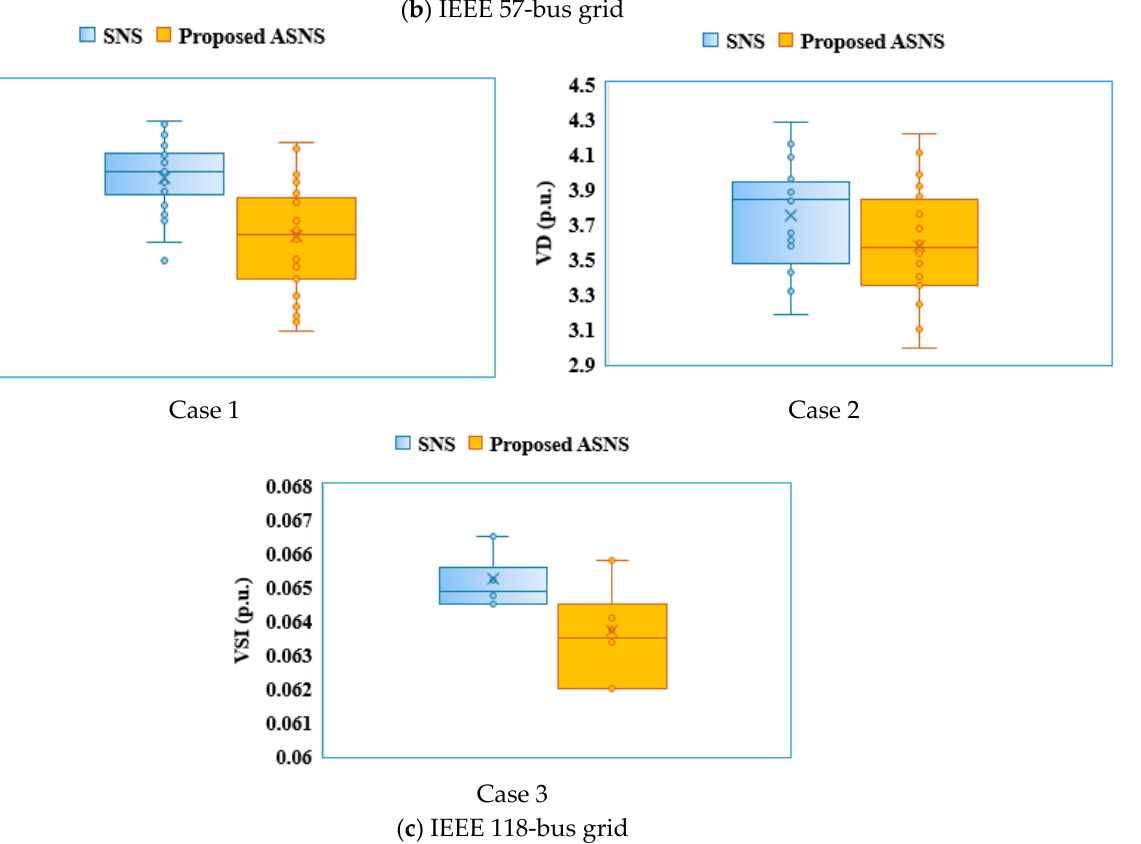
Figure 15. Box and Whiskers plot for the SNS and proposed ASNS of the IEEE 30-, IEEE 57-, and IEEE 118-bus grids. Table 14. Detailed robustness indices for Cases 1-3 of the IEEE 30-bus grid.